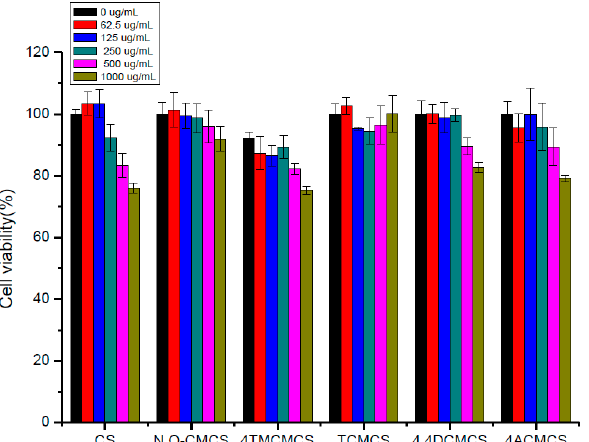
Figure 9. The cytotoxicity of CS, N, O-CMCS , and Carboxymethyl chitosan containing thiourea salts on L929 cells.